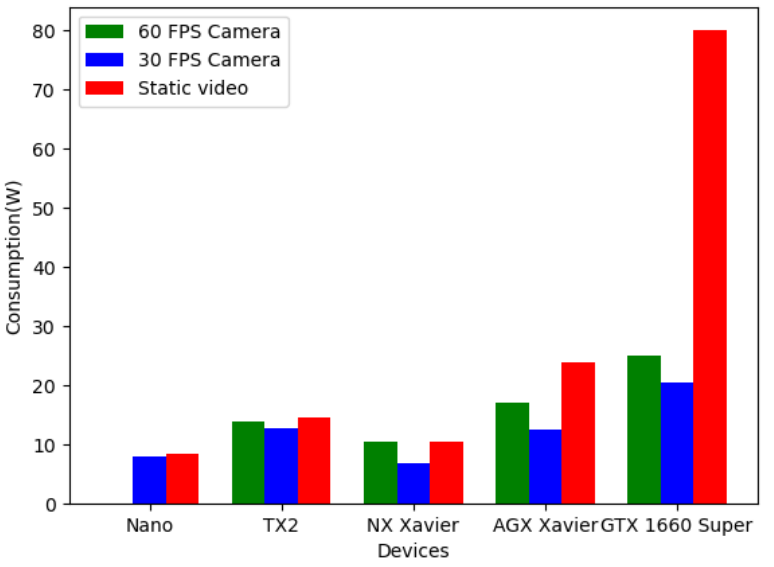
Figure 6. Consumption in watts for each device and